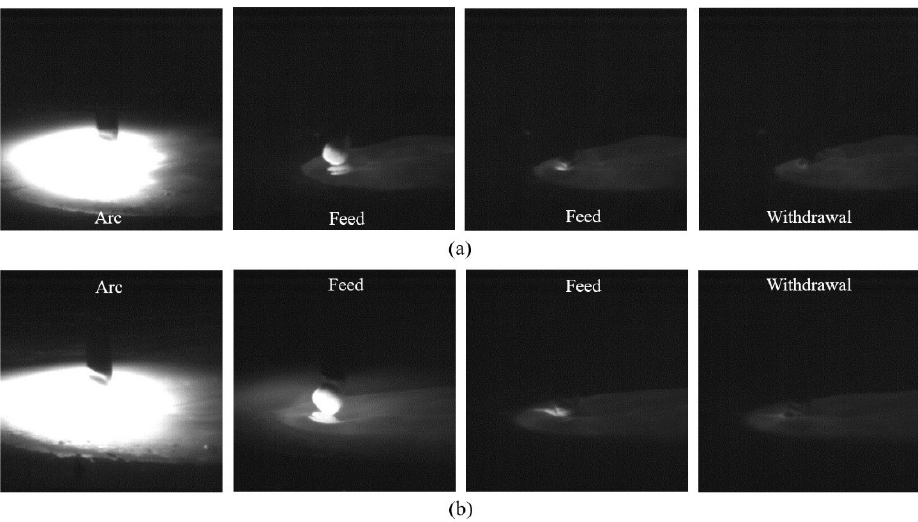
Figure 9. Deformation process of the surface depression of the molten pool under different welding currents: ( a ) Pulse current is 80 A; ( b ) Pulse current is 100 A.